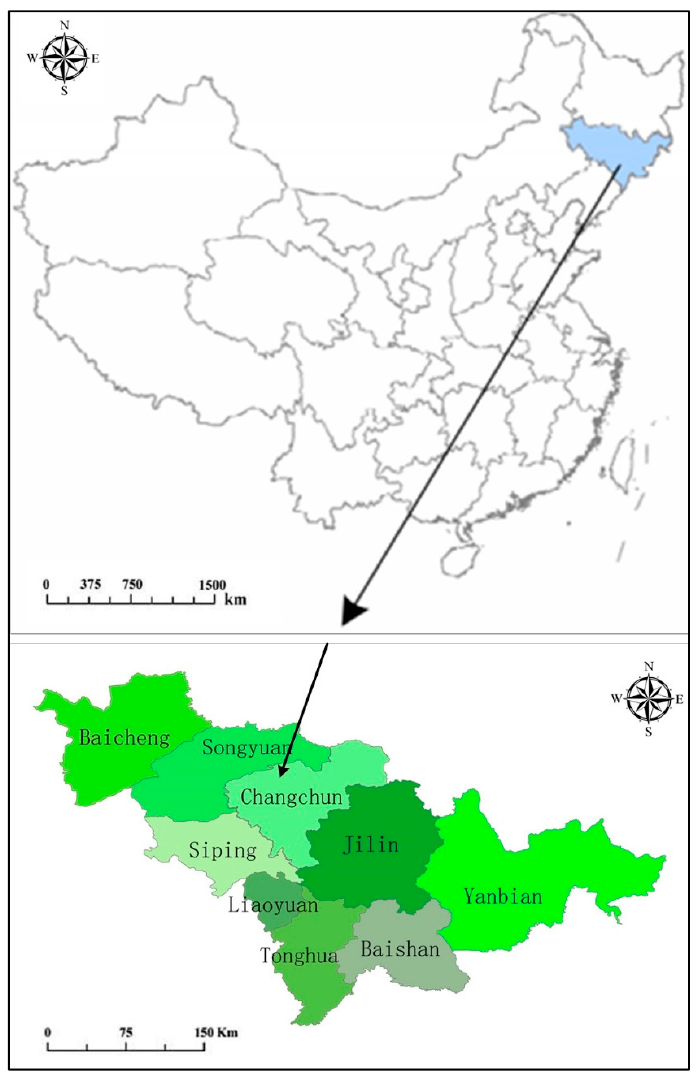
Figure 1. Map of the wetland restoration project (shallow basket lake wetland) in Jilin province, China.